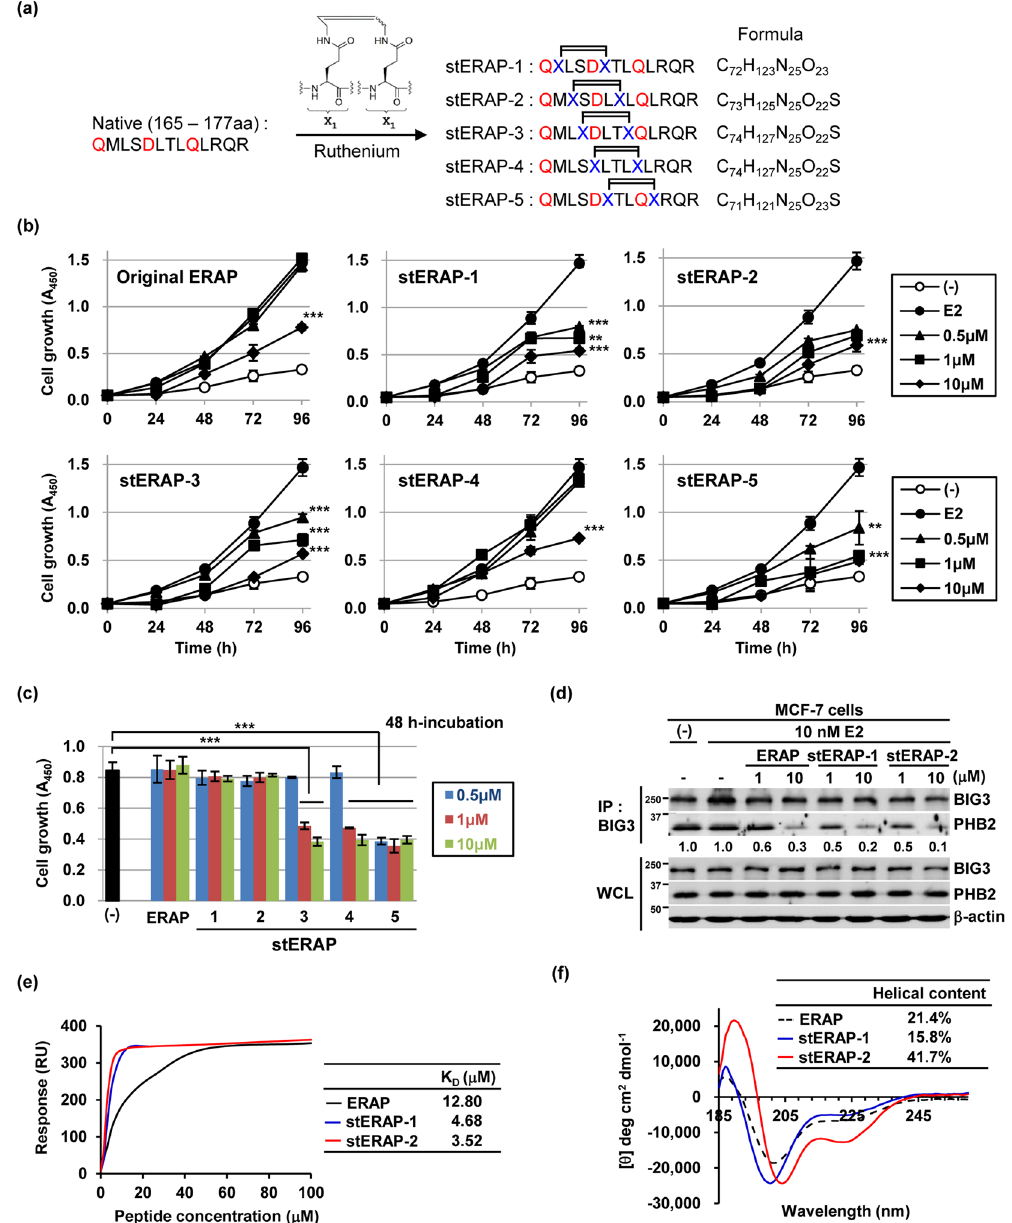
Figure 1. Stapled ERAP has sustained stability and highly sensitive capacity to inhibit the BIG3-PHB2 interaction. ( a ) Primary structures for ERAP and its stapled analogs. ( b , c ) An MTT assay evaluating the inhibitory effects of stapled ERAPs on the growth of 10 nM E2-dependent MCF-7 cells ( b ) and of mammary epithelial MCF-10A cells ( c ). Cells were given a single treatment at 0 h. These data represent the mean ± s.d. of three independent experiments ( ** P < 0.01 and *** P < 0.001 via two-sided Student’s t -tests). ( d ) The inhibitory effects of stapled ERAP treatment on BIG3-PHB2 interactions in MCF-7 cells. ERAP was used as a positive control for the inhibition of the BIG3-PHB2 interaction. ( e ) In vitro direct interaction of stapled ERAPs (stERAP-1 and -2) and recombinant PHB2 discerned by surface plasmon resonance systems. ( f ) CD spectra and α -helical content of ERAP and stERAP analogs (stERAP-1 and -2) in 10 mM sodium phosphate buffer (pH